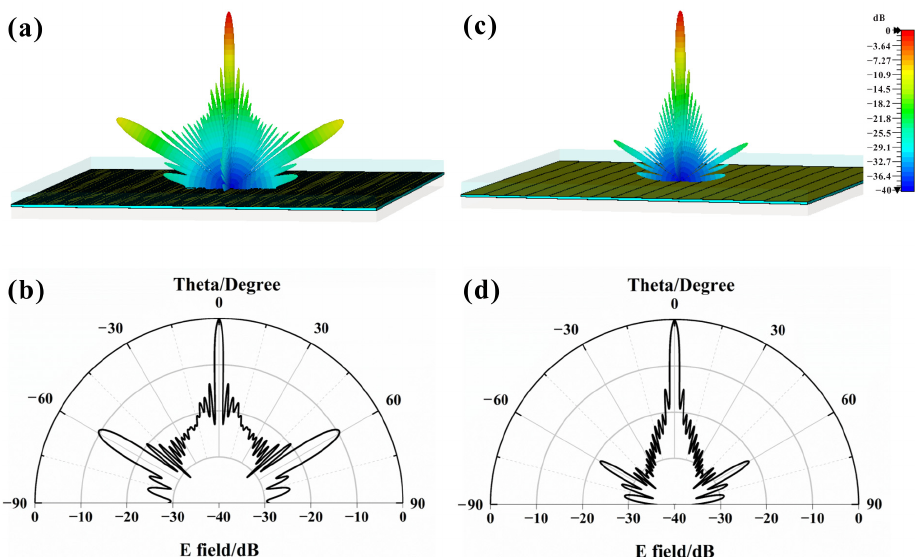
Figure 2. The far-field radiation patterns for ( a , b ) CSRR-based metasurface grating and ( c , d ) metallic strip-based grating at 0.87 THz. ( a , c ) 3D far-field patterns; ( b , d ) 1D far-field patterns. In simulation, both the two 1D gratings have 16 lines.